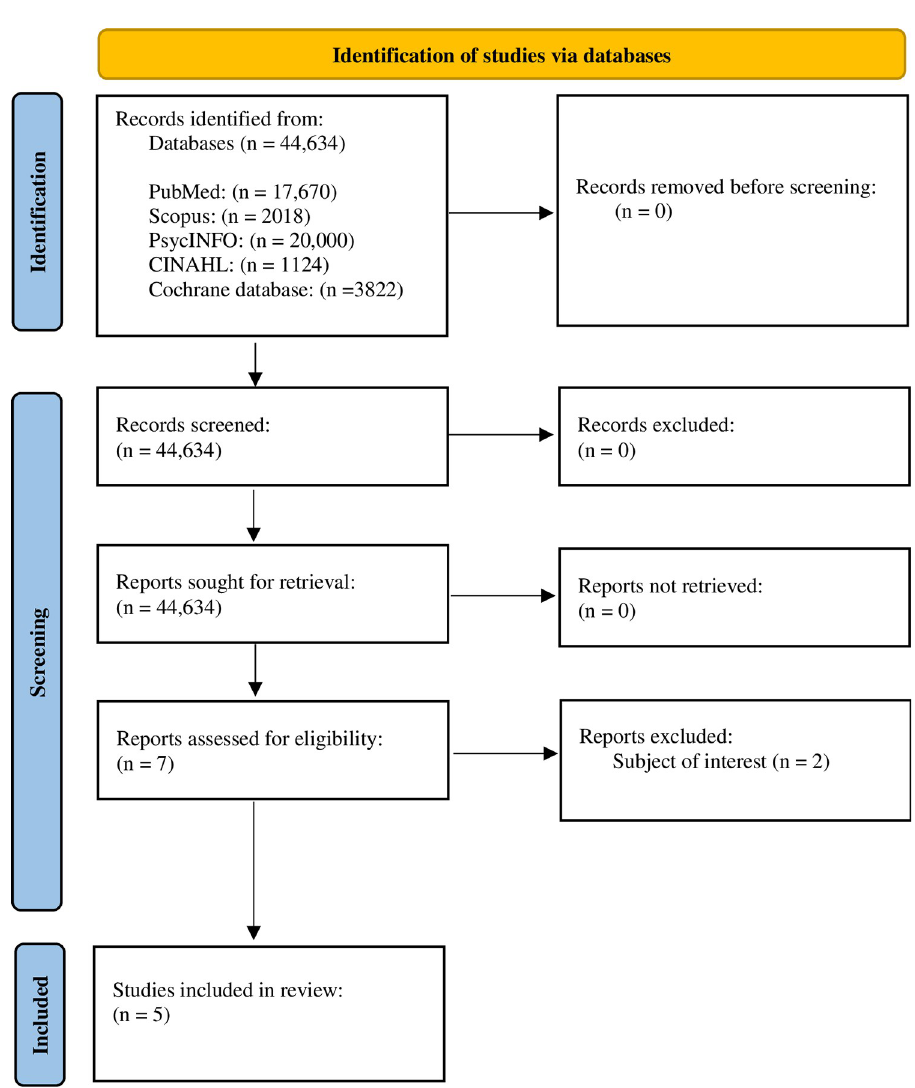
Fig 1. PRISMA flow diagram for the screening and selection of